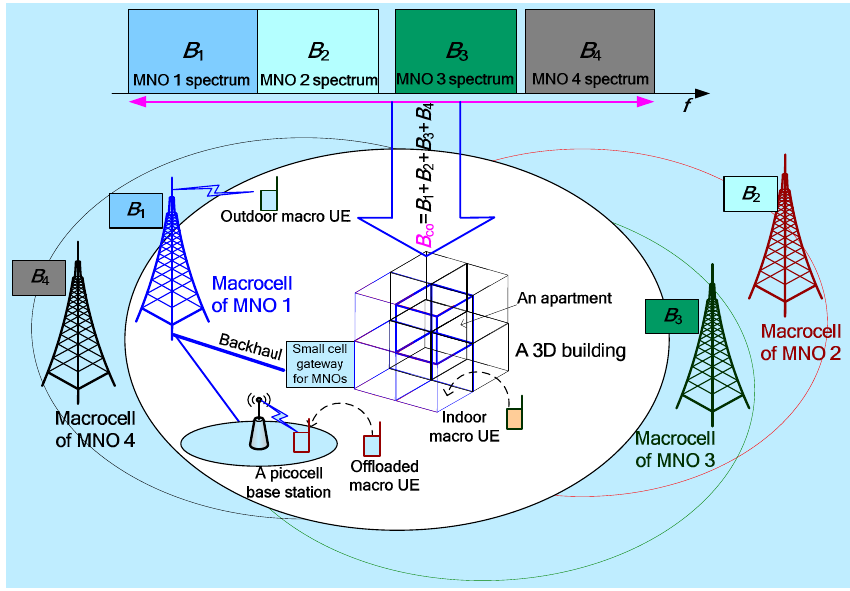
Figure 1. System architecture for x m = 4 MNOs [12].